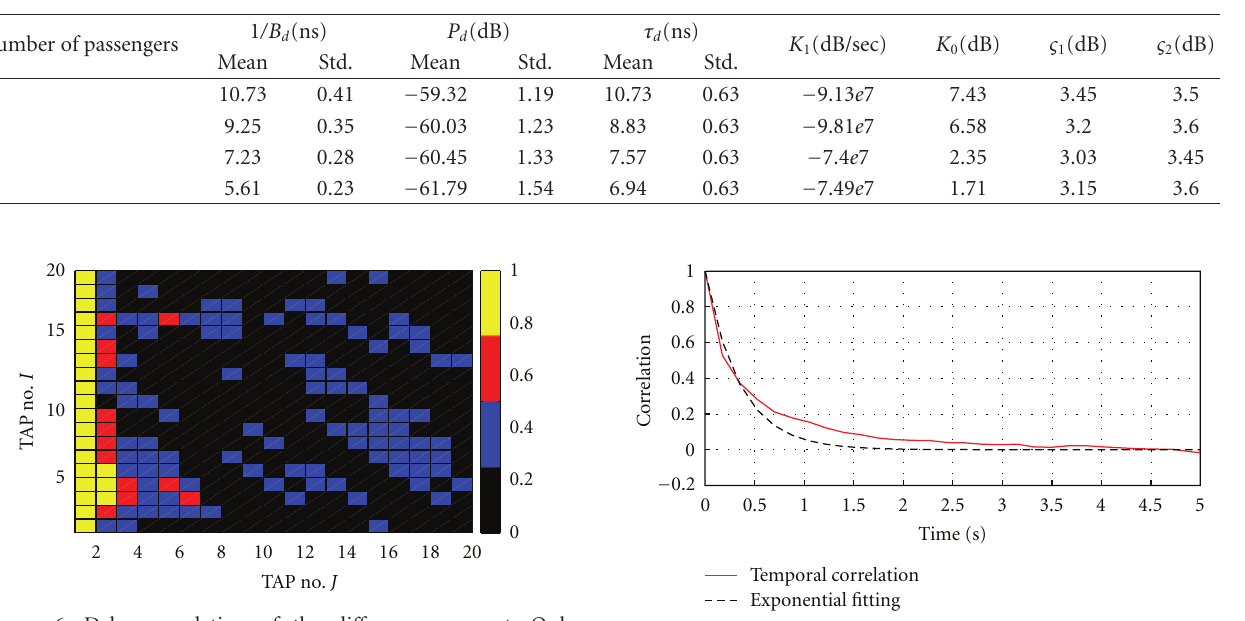
Table 2: Model parameters.